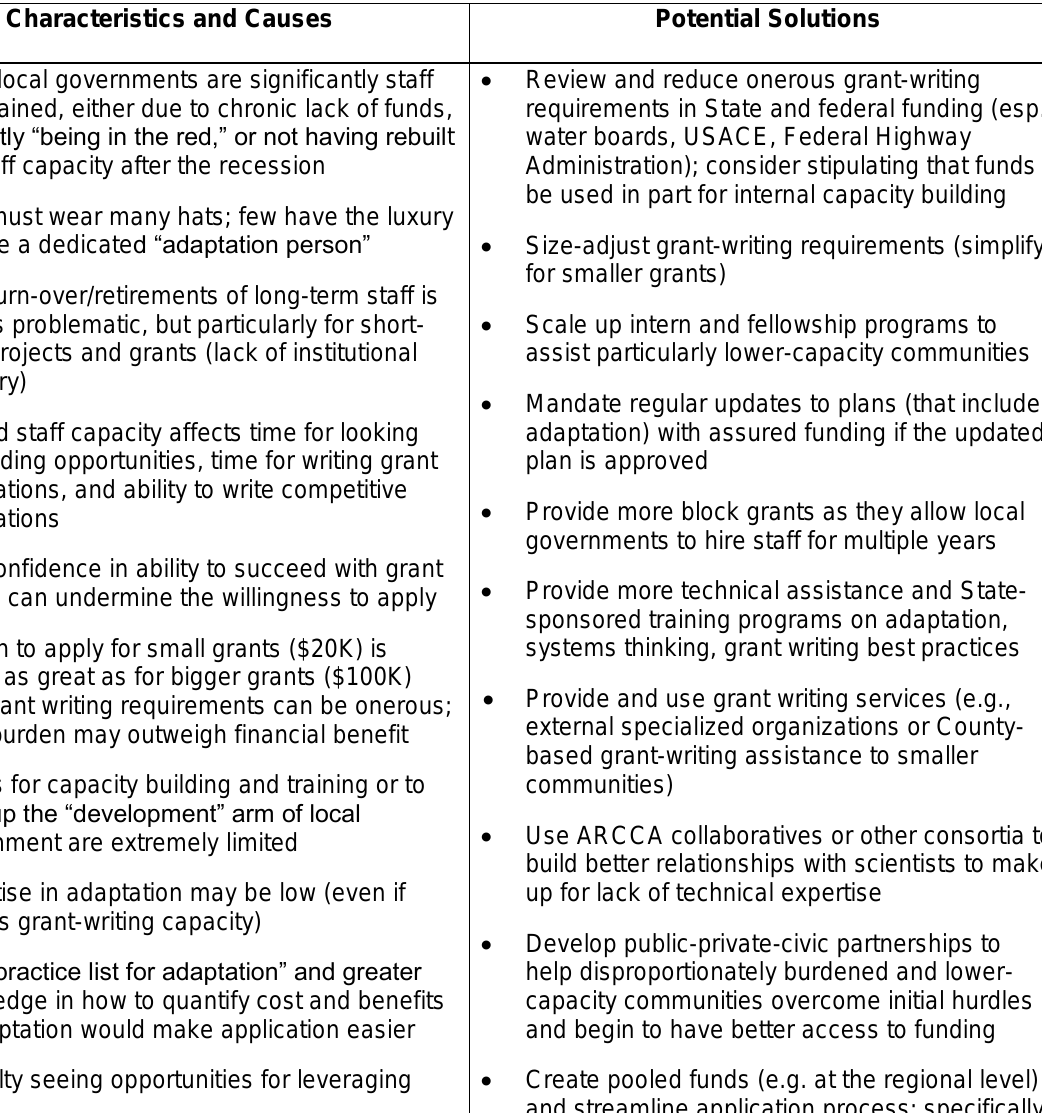
Table A2.10: Characteristics, Underlying Causes and Potential Solutions to